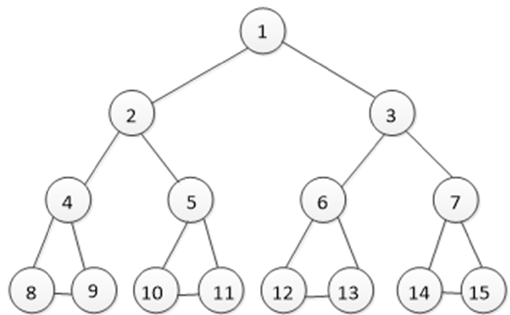
Figure 4. Network topology (Numbers 1–15 represent satellite nodes at different altitudes) (time T1).